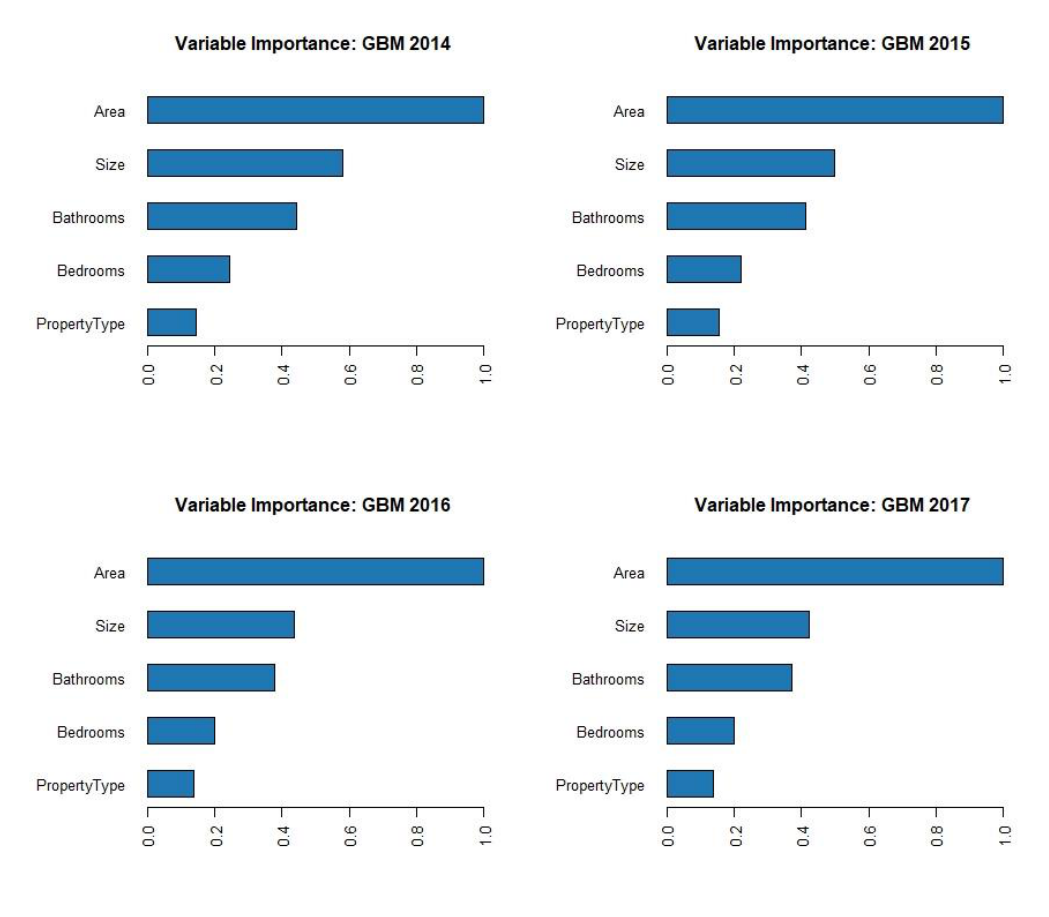
Figure 4: Variable Importance